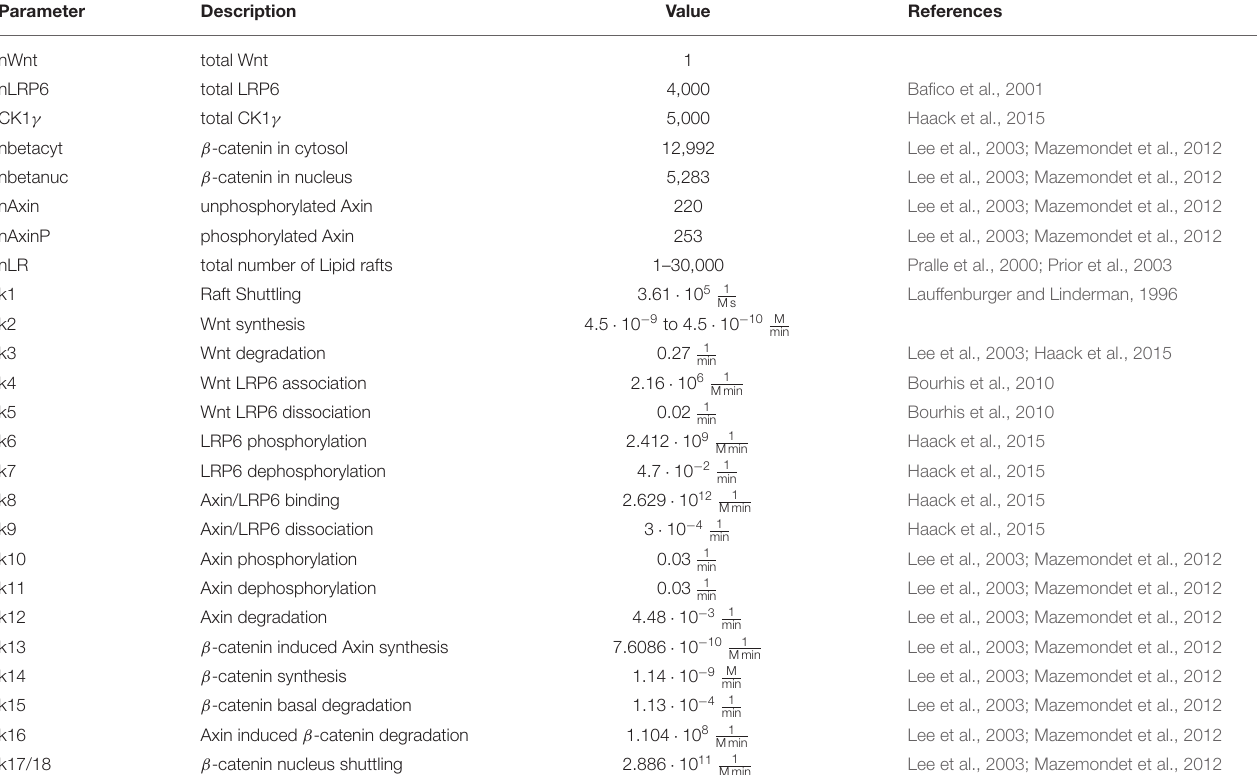
TABLE 1 | Parameter and reference values of the model as depicted in Figure 2 .